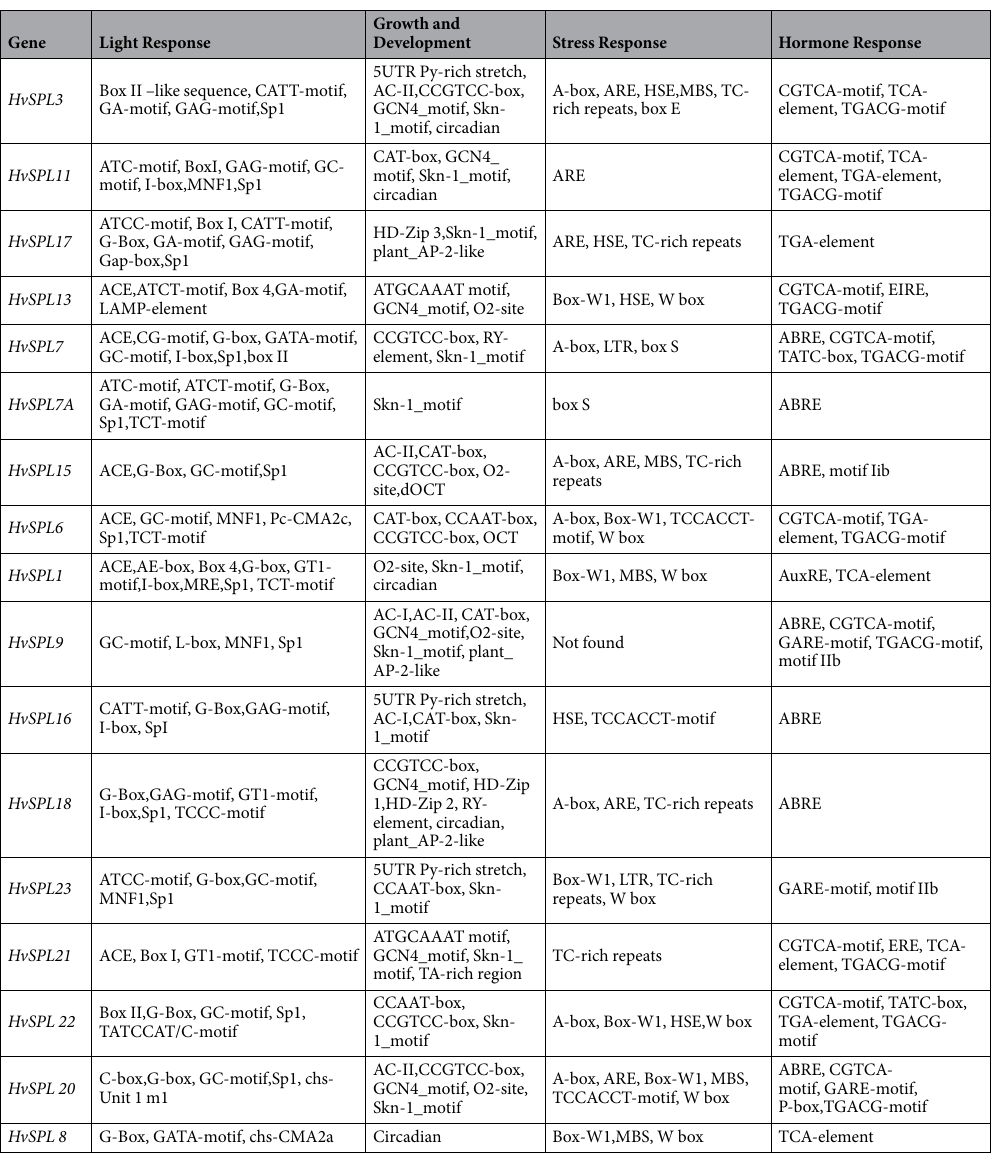
Table 2. Cis -regulatory elements predicted in promoter region of HvSPL